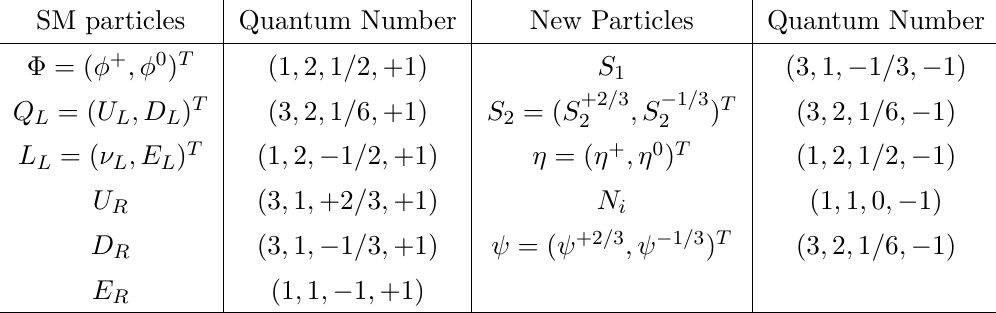
Table 1 . The corresponding quantum numbers of the SM particles and new particles under the symmetry SU(3) C × SU(2) L × U(1) Y × Z 2